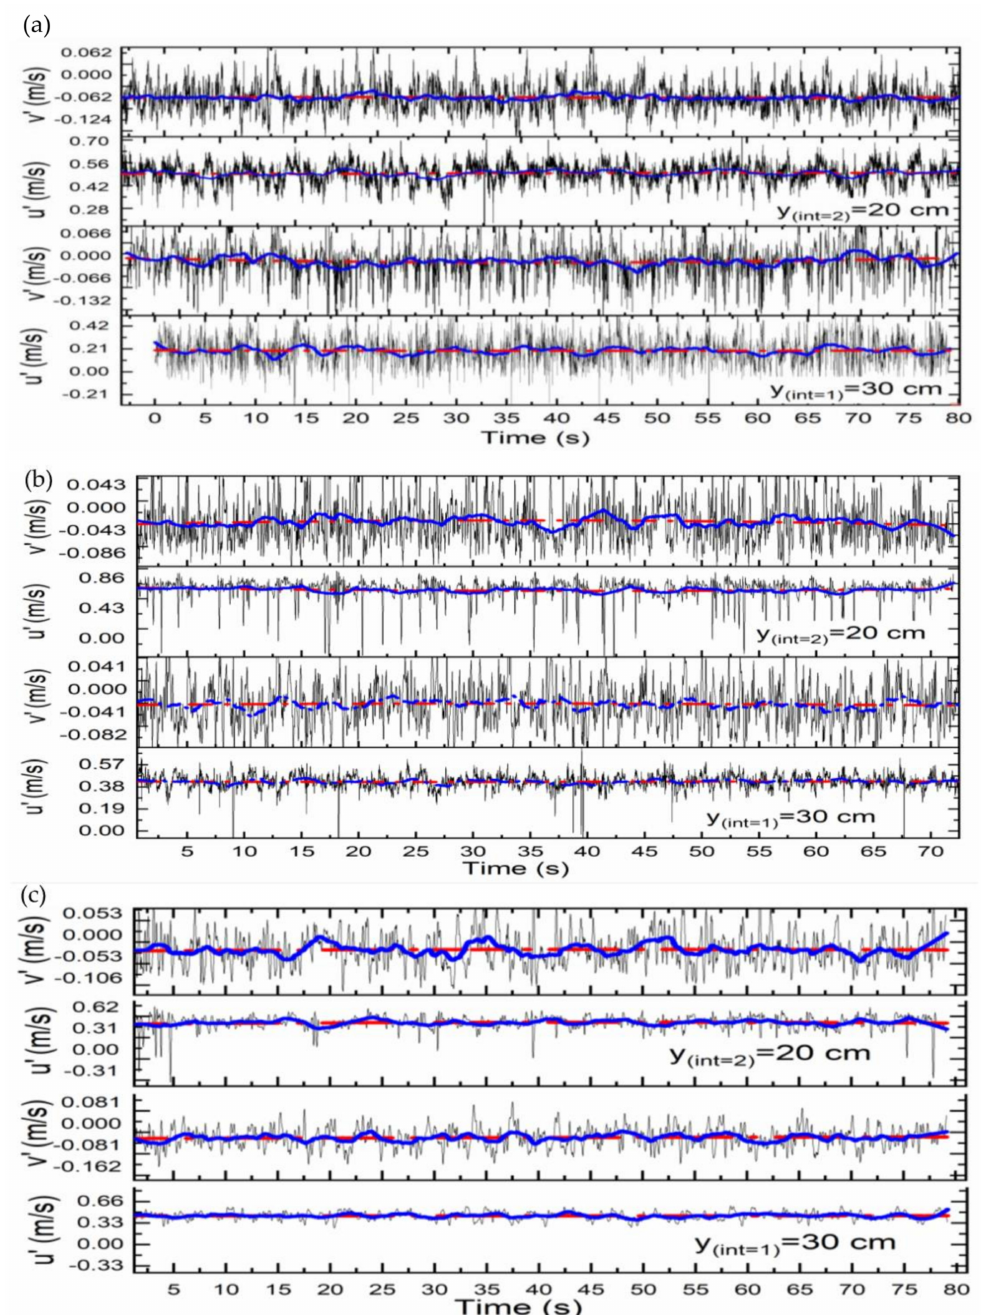
Figure 6. Time series of streamwise ( u (cid:48) ) and lateral velocities ( v (cid:48) ) for depth ratio ( Dr ) being ( a ) 0.1, ( b ) 0.3 and ( c ) 0.5 at the interface of y int = 2 = 20 cm with h = 0.85 cm and y int = 1 = 30 cm with h = 0.45 cm. The black line is the raw signal, the blue line is the low-pass filtered signal and the solid red line is the mean value of the raw